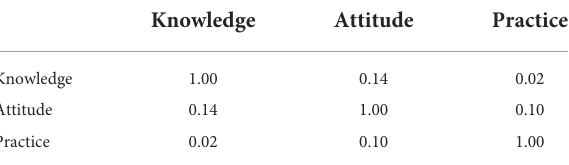
TABLE 4 Correlation between knowledge, attitude and practice total score.